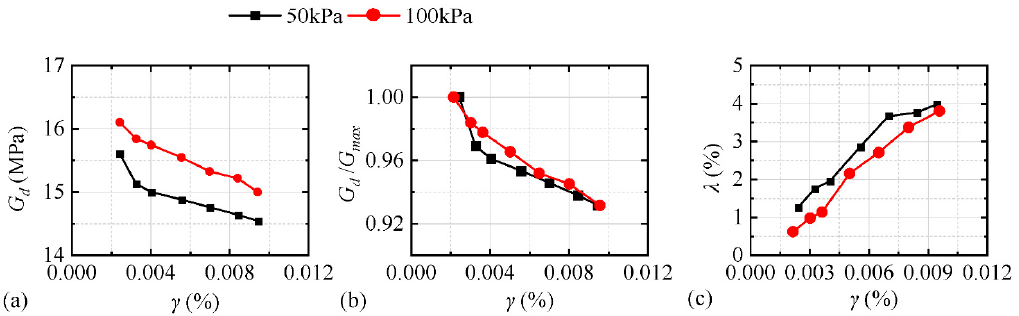
Figure 8. Test results of sawdust kaolin: ( a ) Dynamic shear modulus curve of sawdust kaolin, ( b ) Nor-